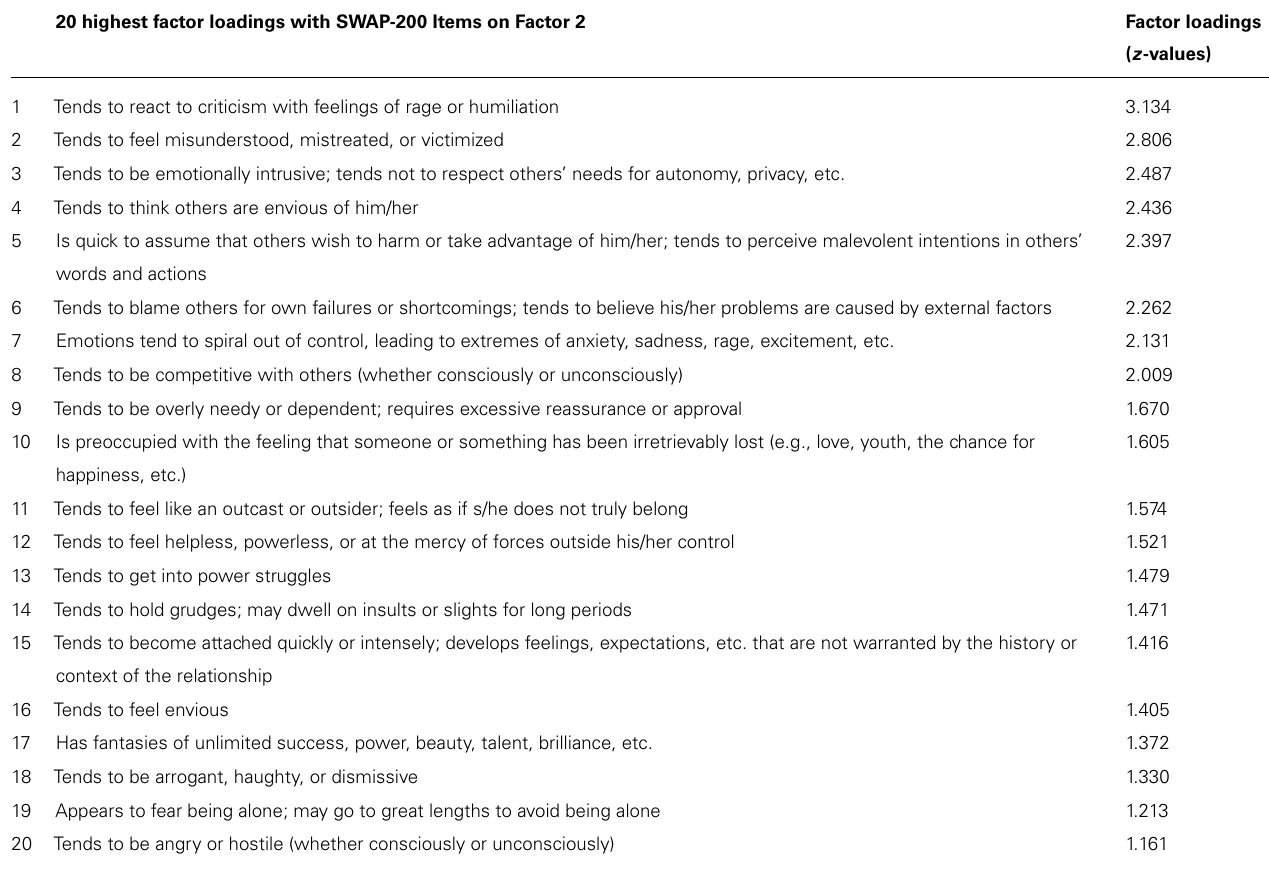
Table 2 |The 20 highest factor loadings on SWAP-200 items for Q-Factor 2 (“Emotional-Hostile-Externalizing”). 20 highest factor loadings with SWAP-200 Items on Factor